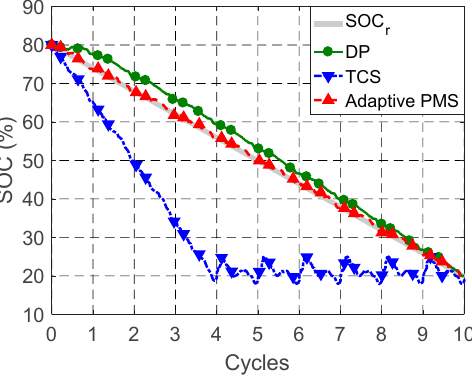
Figure 16. SOC responses for 10 NEDC cycles.